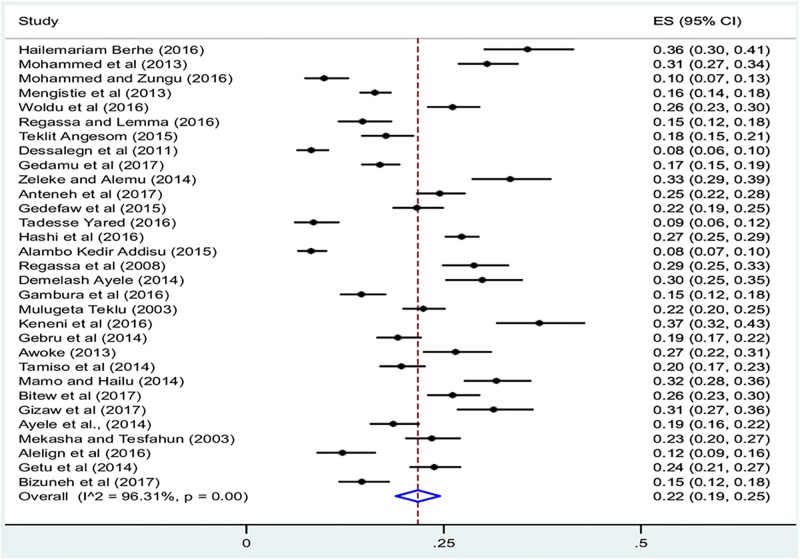
Forest plot of the pooled prevalence of diarrhea among under-five children in Ethiopia.